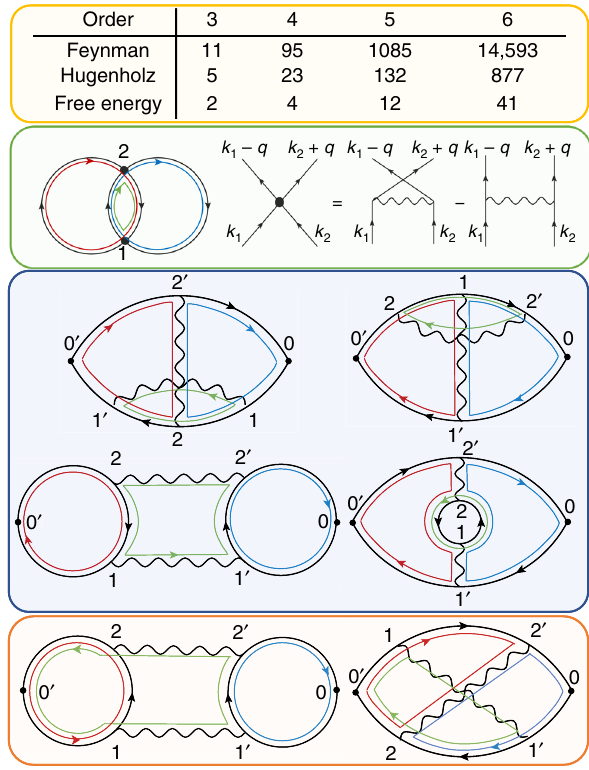
Fig. 1 Grouping of Feynman diagrams. The grouping is achieved by leveraging the fermionic crossing symmetry and the free-energy generating functional. Orange top box shows the number of Feynman/Hugenholtz/ Free-energy Hugenholtz diagrams at orders 3 – 6, excluding the Hartree – Fock sub-diagrams (see Supplementary Note 1). The green panel on the left and the right shows an example of the free-energy Hugenholtz diagram, and how is the Hugenholtz vertex related to the standard Feynman diagram. Note that a single Hugenholtz diagram with N vertices (black dots) represents up to 2 N standard Feynman diagrams with alternating signs. By attaching two external vertices to different propagators in the Hugenholtz free-energy diagram in the green box, one generates four topologically distinct groups of standard Feynman diagrams for the polarization function. Two of them are shown in the blue and orange box below. By the process of attaching external vertices to a single Hugenholtz free-energy diagram, we generate 10 out of 11 standard Feynman diagrams for the polarization at the third order. The color lines represent our choice for momentum loops, which are uniquely determined by the choice of the loops in the free-energy Hugenholtz diagram. The external momentum is added through the shortest path connecting two external vertices. Note that such grouping of diagrams allows us to calculate the weight of all diagrams in this fi gure with only eight different electron propagators, instead of expected 36. The above protocol can generate multiple copies of the same Feynman diagram. We tested two approaches: (a) we keep one copy to avoid double counting; (b) we keep all copies and precompute the symmetry factors, and we notice somewhat better performance of scheme